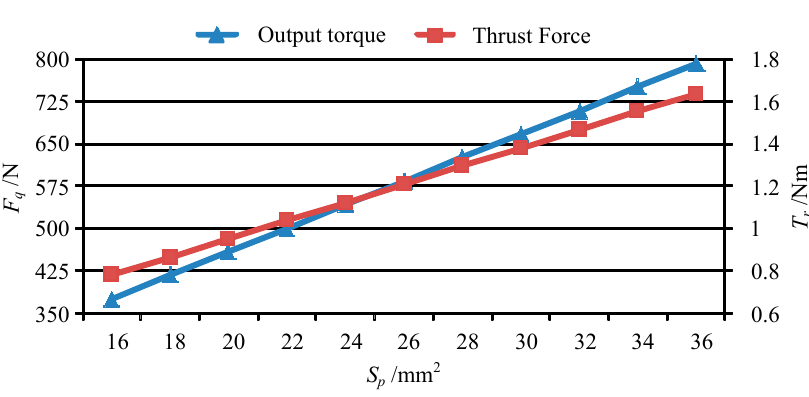
Figure 17. The output torque and thrust force vary with S p .